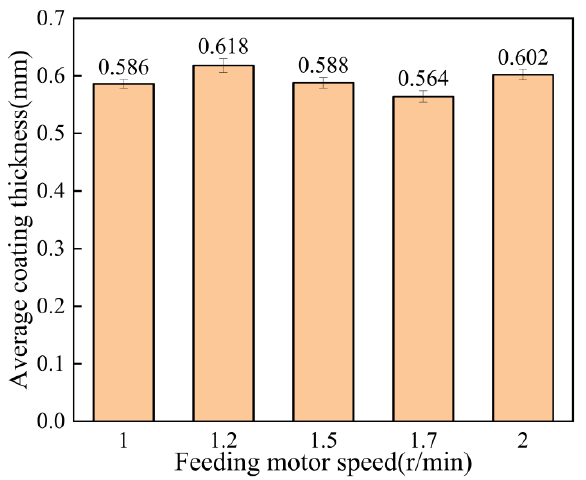
Figure 12. Average coating thickness at different feeding motor speeds.